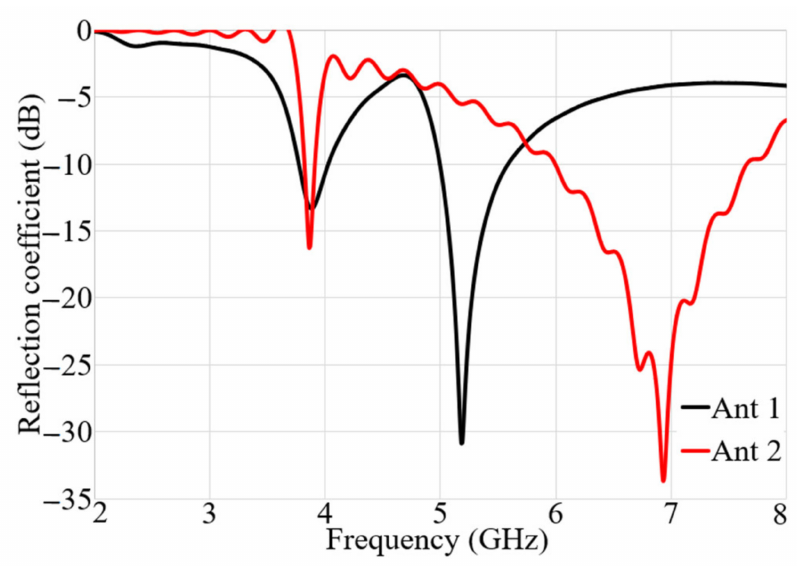
Figure 5. Ant 1 and Ant 2 (cid:48) s reflection coefficient results.